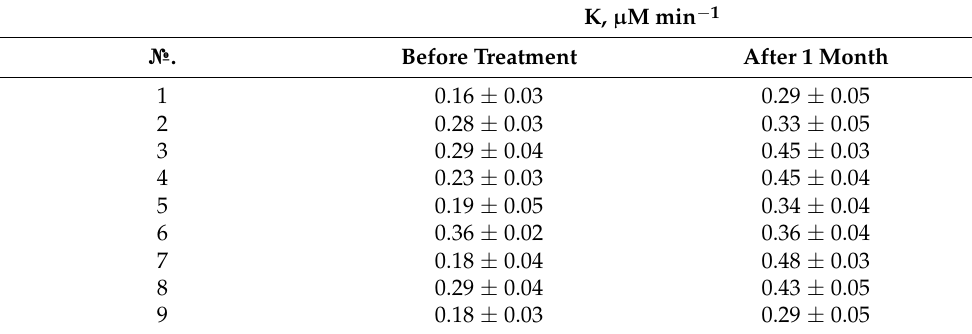
Table 3. The values of the total activity of antioxidants in the blood serum of patients with an established diagnosis of chronic cerebral ischemia ( p = 0.95, n = 3) during treatment with Mexidol per os. K, µ M min − 1 № . Before Treatment After 1